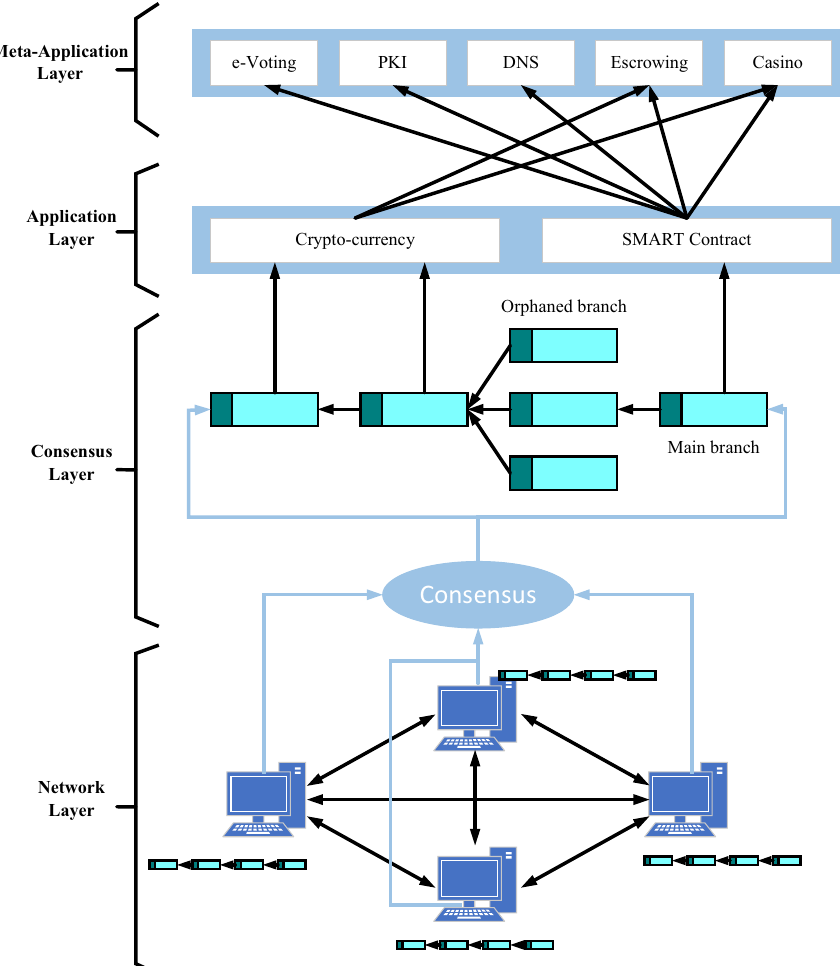
Fig. 2 Layered structure of blockchain